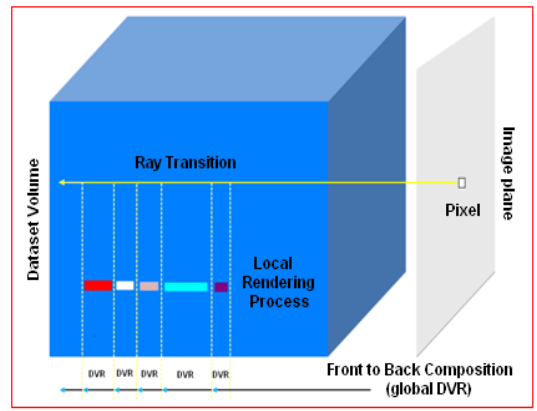
Figure 15. Double rendering